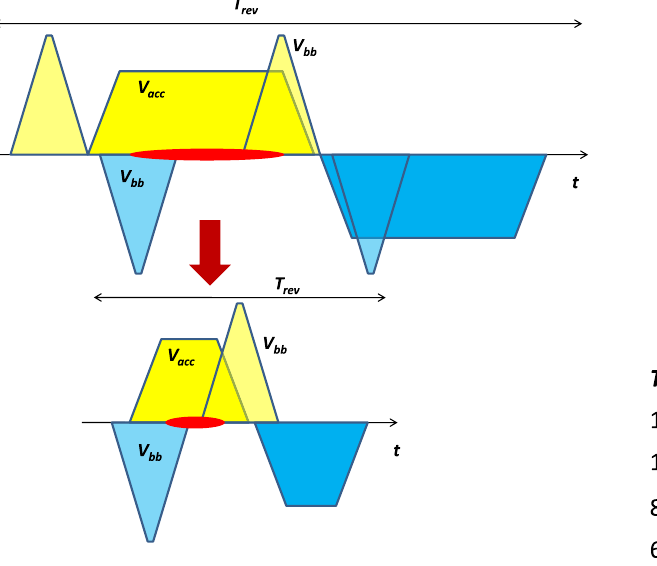
FIG. 3 (color online). Schematic view of capture and accel- eration by V and V , respectively, at early stage (top) and late bb acc stage (bottom) of acceleration.